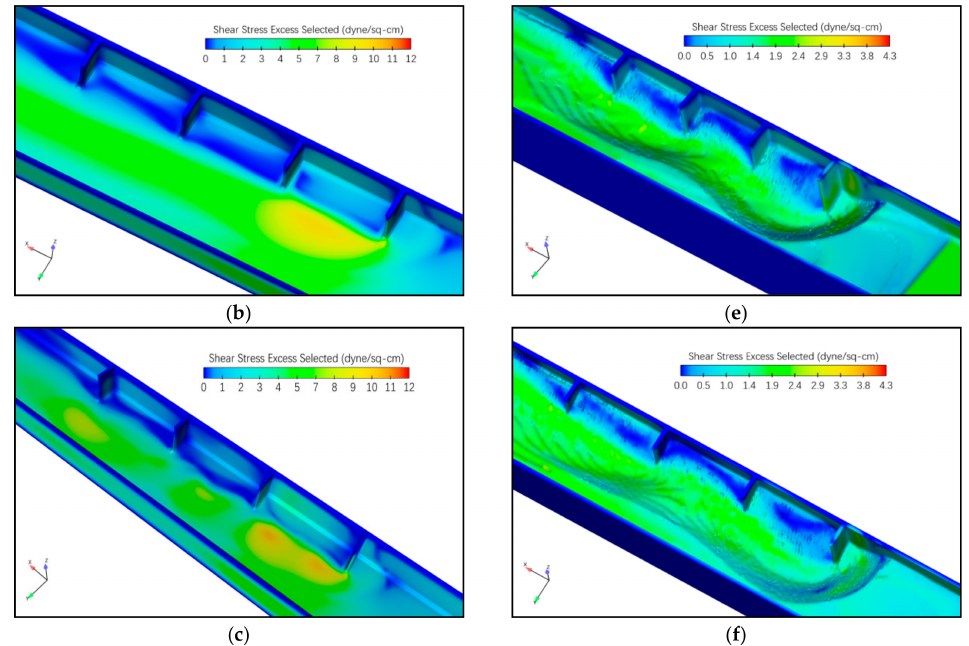
Figure 9. The shear stress contours of di ff erent spur dike spacing. ( a ) fixed bed for 2 l spacing; ( b ) fixed bed for 3 l spacing; ( c ) fixed bed for 4 l spacing; ( d ) movable bed for 2 l spacing; ( e ) movable bed for 3 l spacing; ( f ) movable bed for 4 l spacing.